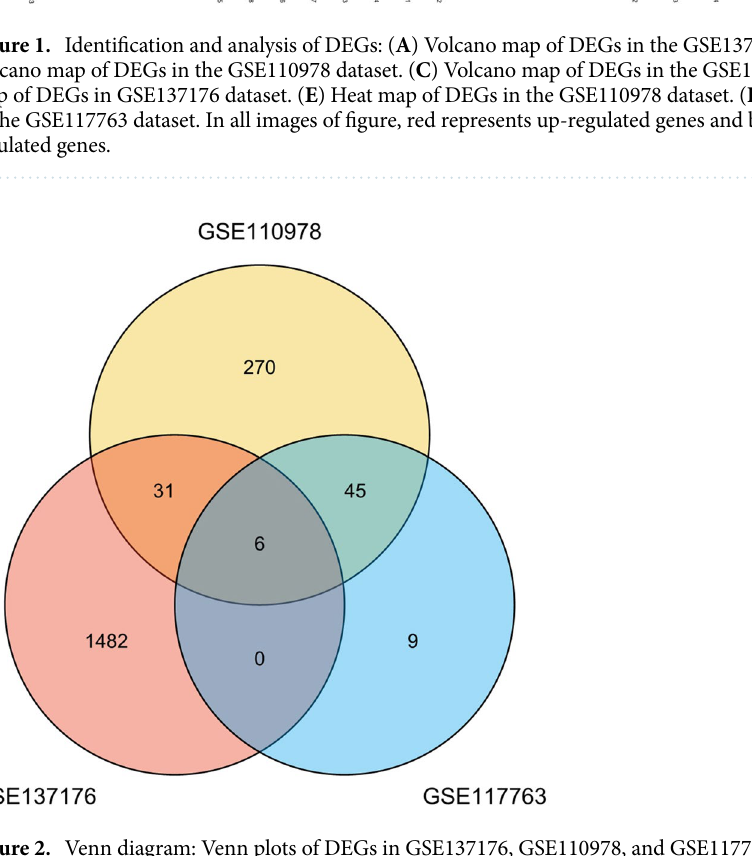
Figure 2. Venn diagram: Venn plots of DEGs in GSE137176, GSE110978, and GSE117763 data sets, and the overlapped part represents the common DEGs in the three data sets, 6 in